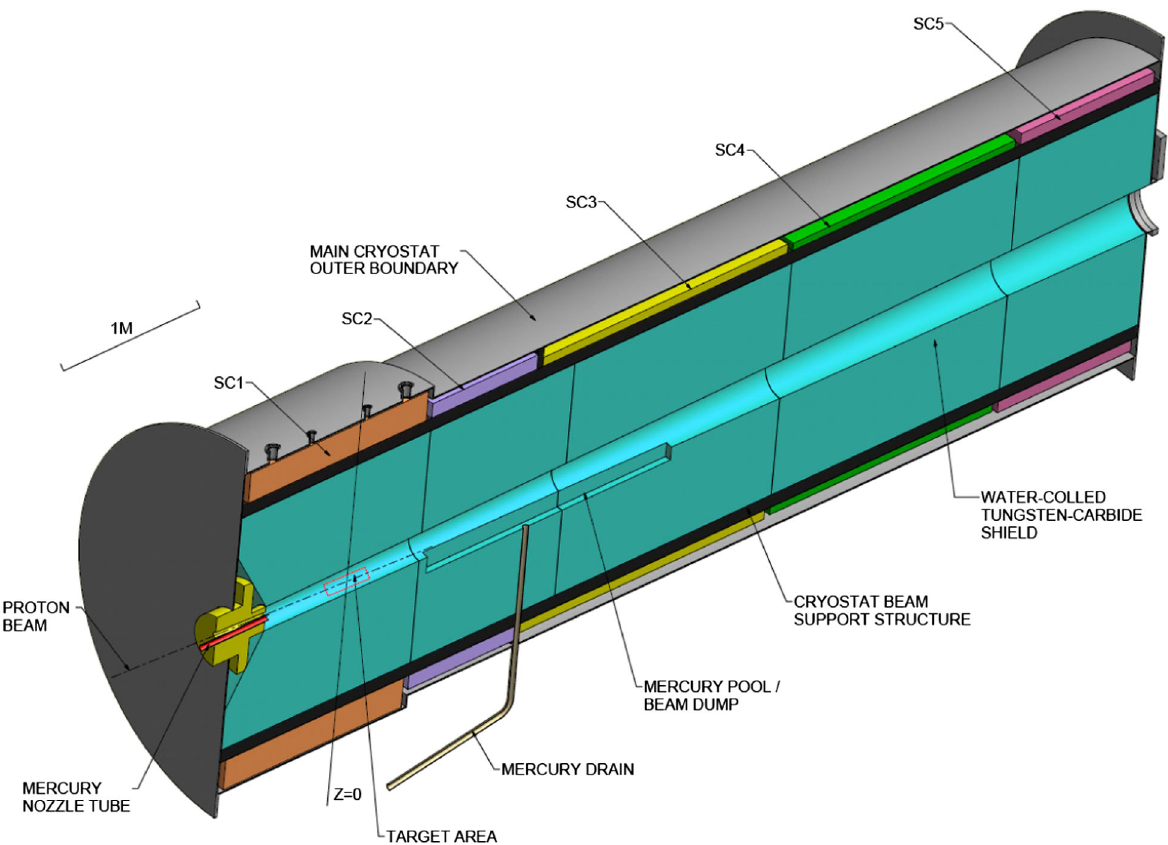
FIG. 8. Schematic of the MOMENT target station.